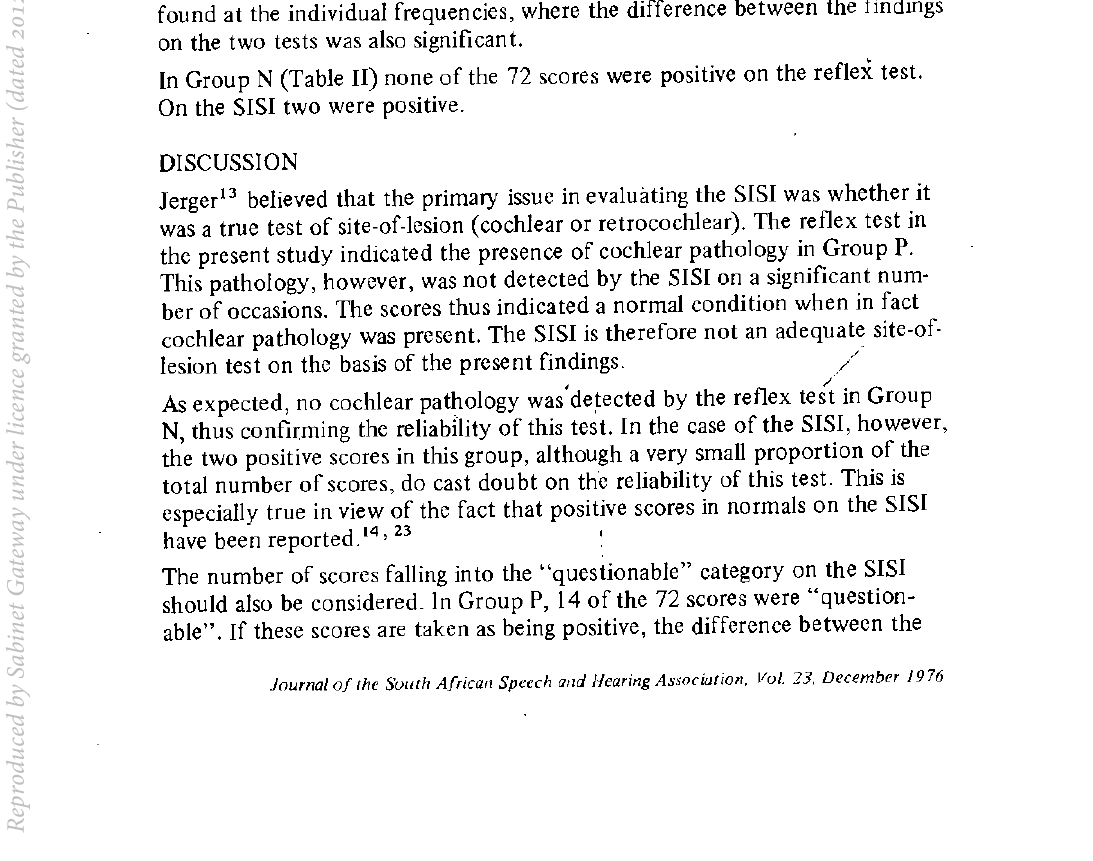
Forty-nine of the 72 scores were positive on the reflex test; 11 of the 72 scores were positive on the SISI. There were thus 38 more positive scores on the reflex test than on the